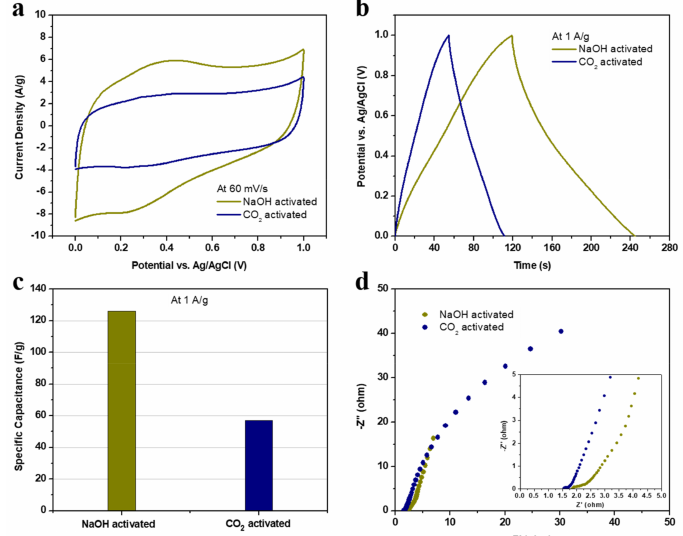
Figure 6. The electrochemical performance of the physically CO 2 - and chemically NaOH-activated carbon electrodes in terms of ( a ) a cyclic voltammetry curve at 60 mV/s, ( b ) a galvanostatic charging– discharging plot at 1 A/g, ( c ) specific capacitance values at 1 A/g, and ( d ) a Nyquist plot of electro- chemical impedance spectroscopy with the high-frequency region in the